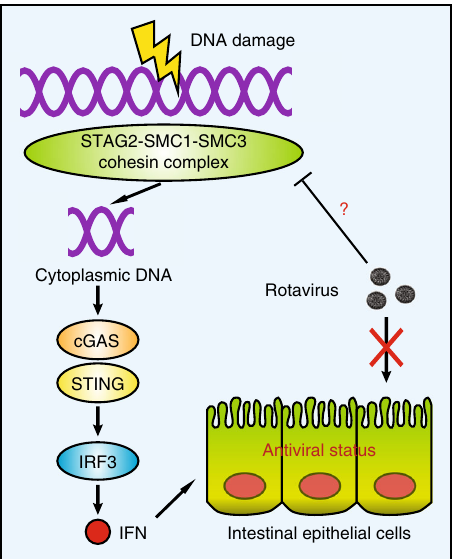
Fig. 5 Working model of RV – cohesin interaction. Host genomic DNA damage induced by cohesin de fi ciency led to an increase in the levels of cytoplasmic DNA, which feeds into the cGAS-STING DNA-sensing pathway to activate IFN and ISG expression. These processes enable the host cells to enter an antiviral status and render them resistant to rotavirus infection. Future studies will focus on whether rotavirus has evolved strategies to dampen the host DNA damage response and subsequent IFN production. Cohesin is multimeric nuclear protein complex that includes STAG2 and is associated with vital roles during cell division. Here, in a genome-wide CRISPR-Cas9 screen, the authors identify a novel role of STAG2 as a crucial component of the innate immune response to